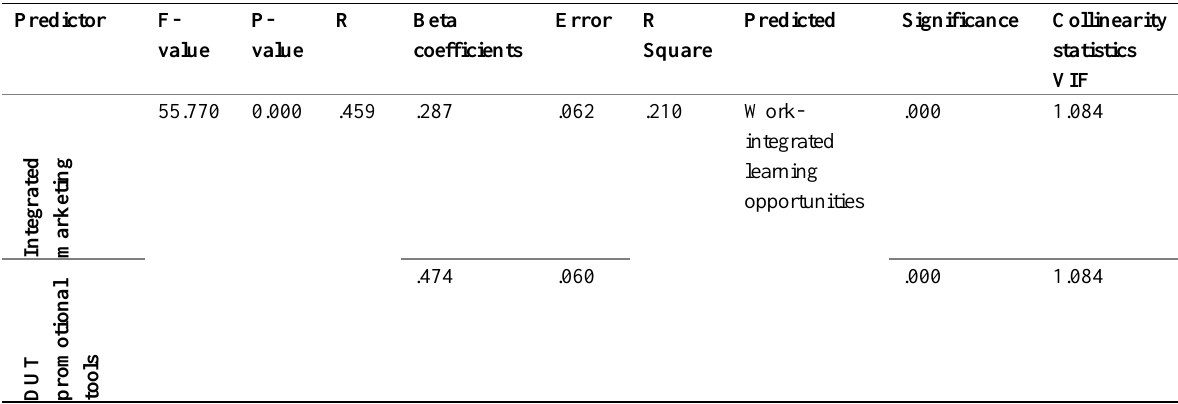
Table 5: Multiple regression on the predictors of work-integrated learning